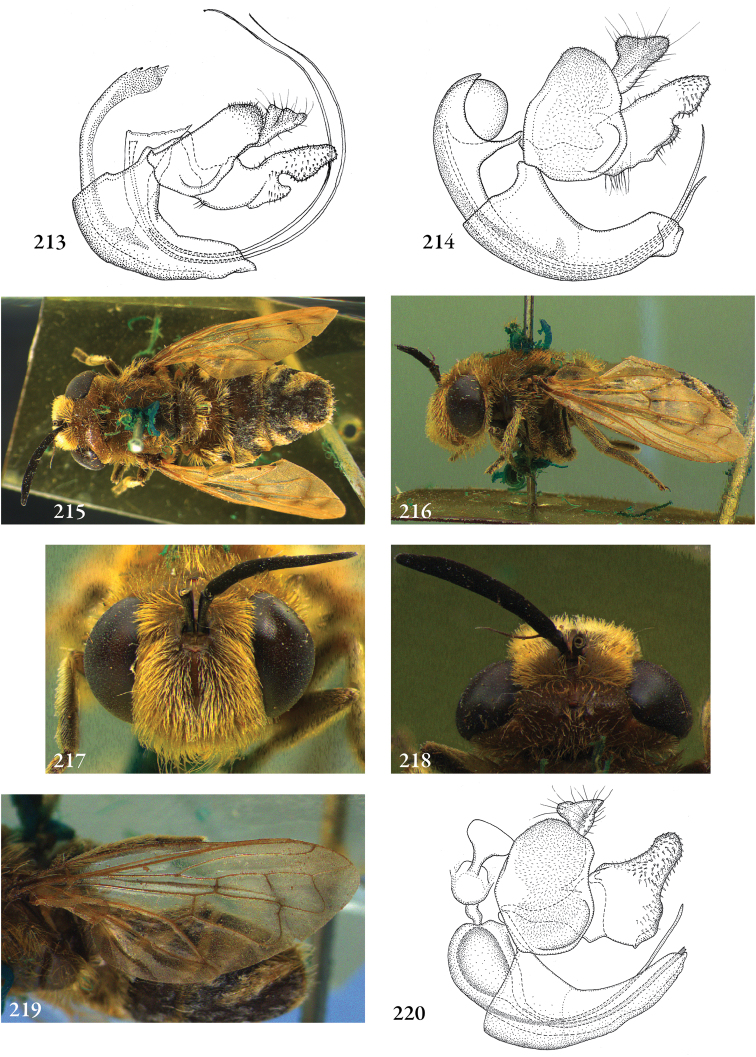
213–214
Microdon (Microdon), male genitalia: 213
Microdon mandarinus (holotype) 214 Microdon yunnanensis (holotype) 215–220
Microdon (Myiacerapis) villosus male (holotype): 215 habitus dorsal 216 habitus lateral 217 head frontal 218 head dorsal 219 wing 220 genitalia lateral.